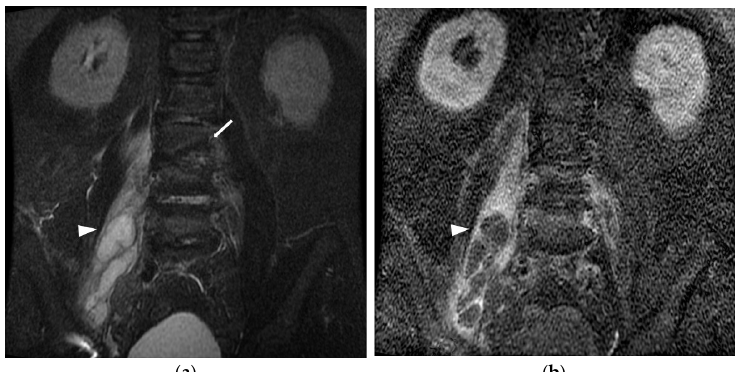
Figure 1. Pyogenic spondylodiscitis complicating iliopsoas abscess in a 58-year-old male. ( a ) Mag- netic resonance (MR) image of L-S spine of coronal short T1 inversion recovery (STIR) sequence showed cortical discontinuities and erosions of endplates (arrow) of L2, L3 vertebras with hyperin- tense of right iliopsoas muscle associated with intramuscular loculated fl uid collections (arrow- head). ( b ) Contrast-enhanced MRI T1 weighted image (WI) with fat suppression showed prominent rim enhancement of loculated fl uid collection in the right iliopsoas muscle, which was compatible with intramuscular abscess of the right iliopsoas muscle (arrowhead).